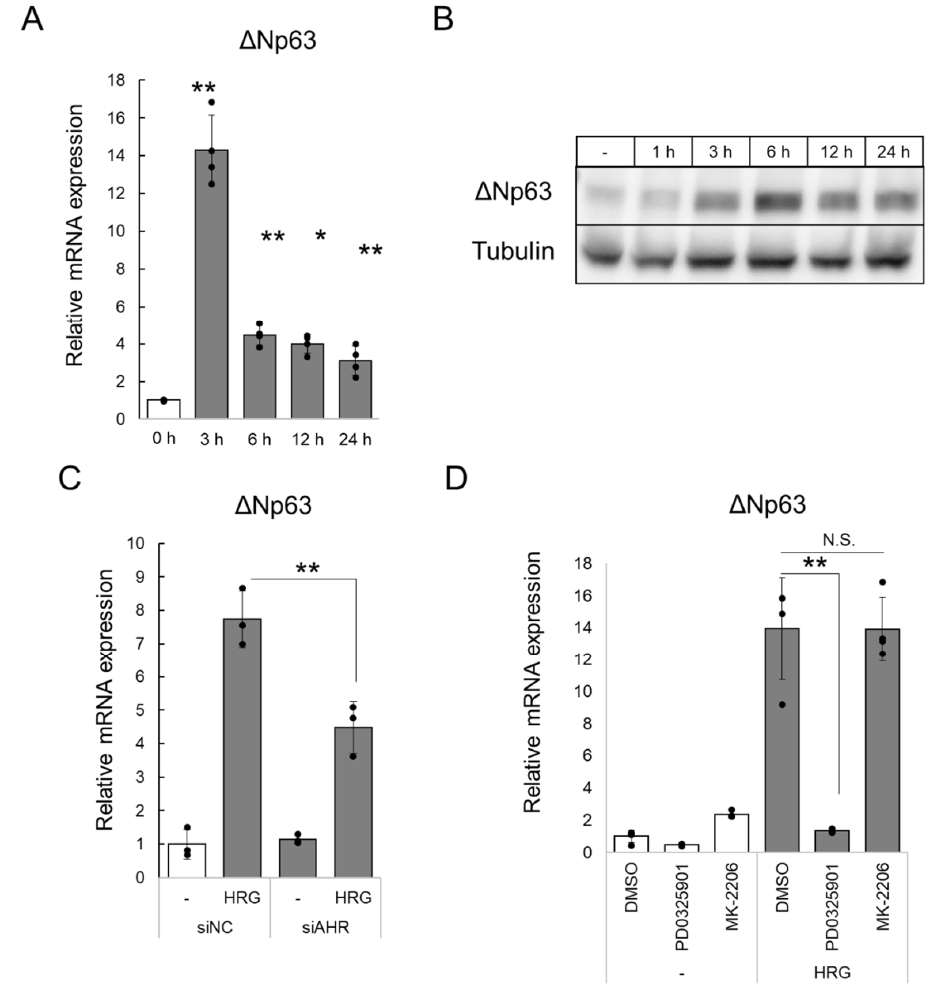
Figure 3. Upregulation of ∆Np63 expression via AHR mediated by HRG. ( A ) HER2-5 cells were cultured in medium with low serum (2% charcoal-stripped fetal bovine serum, csFBS DMEM) for 24 h and treated with HRG (50 ng/mL) for 3–24 h. Subsequently, the cells were harvested, and ∆Np63 mRNA levels were determined by RT-qPCR analysis and normalized to those of B2M mRNA. The relative mRNA levels are expressed as the average of the fold-induction relative to that in the control (0 h) (mean ± S.D., n = 4). ** p < 0.01; * p < 0.05 (Dunnett’s test vs. 0 h). The depicted results are representative of two independent biological experiments. ( B ) HER2-5 cells were cultured in medium with low serum (2% csFBS DMEM) for 24 h and treated with HRG (50 ng/mL) for 1–24 h. Subsequently, the cells were harvested, whole-cell lysates (10 µ g) were resolved by sodium dodecyl sulfate-polyacrylamide gel electrophoresis, and proteins were detected by immunoblot analysis using antibodies against ∆ Np63 and α -tubulin. ( C ) HER2-5 cells were transfected with siRNA targeting AHR (siAHR, 10 nM) or control siRNA (siNC, 10 nM). After 24 h, the culture medium containing 10% FBS was changed to medium containing low serum (2% csFBS), and the cells were incubated for 21 h. The cells were stimulated with HRG (50 ng/mL) or vehicle (water) for 3 h, and relative mRNA levels were determined (mean ± S.D., n = 3). ** p < 0.01 (Student’s t test). The results are representative of two independent biological experiments. ( D ) HER2-5 cells were cultured in medium with low serum (2% csFBS DMEM) for 24 h and pre-treated with PD0325901 (1 µ M), MK-2206 (1 µ M), or DMSO (solvent control) for 1 h. Then, the cells were stimulated with HRG (50 ng/mL) or vehicle (water) for 3 h, and relative mRNA levels were determined (mean ± S.D., n = 3). ** p < 0.01 (Student’s t test). The results are representative of two independent biological